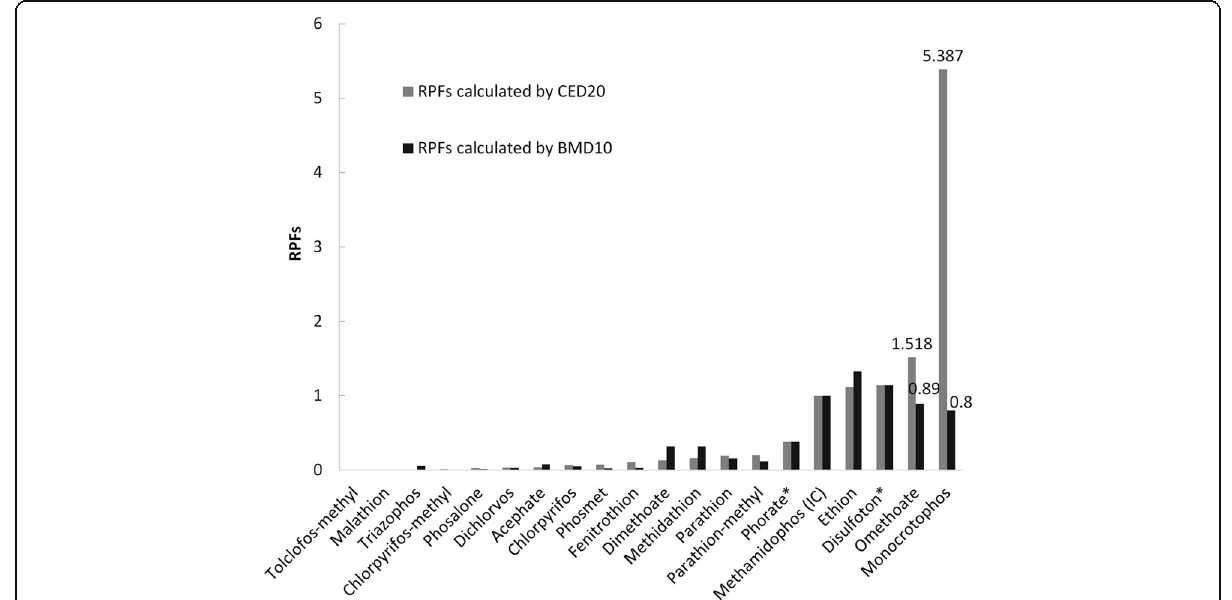
Fig. 2 Two types of RPFs calculated by BMD 10 and CED 20 inhibition in the female rat brain after 21 days exposure to